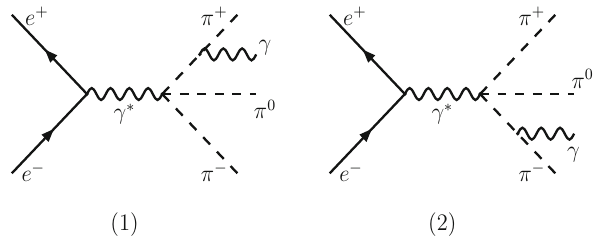
Fig. 10 The Feynman diagrams of process (13) that cause the U ( 1 ) gauge invariance violation